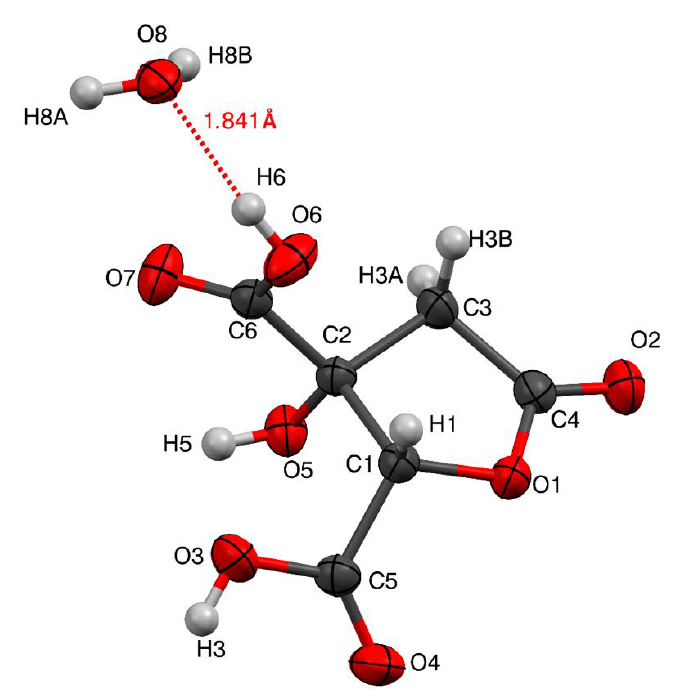
Figure 3. Molecular structure of hibiscus acid isolated from Hibiscus sabdariffa calyces acetonic extract determined by X-ray diffraction. Ellipsoids shown at 50% of probability.